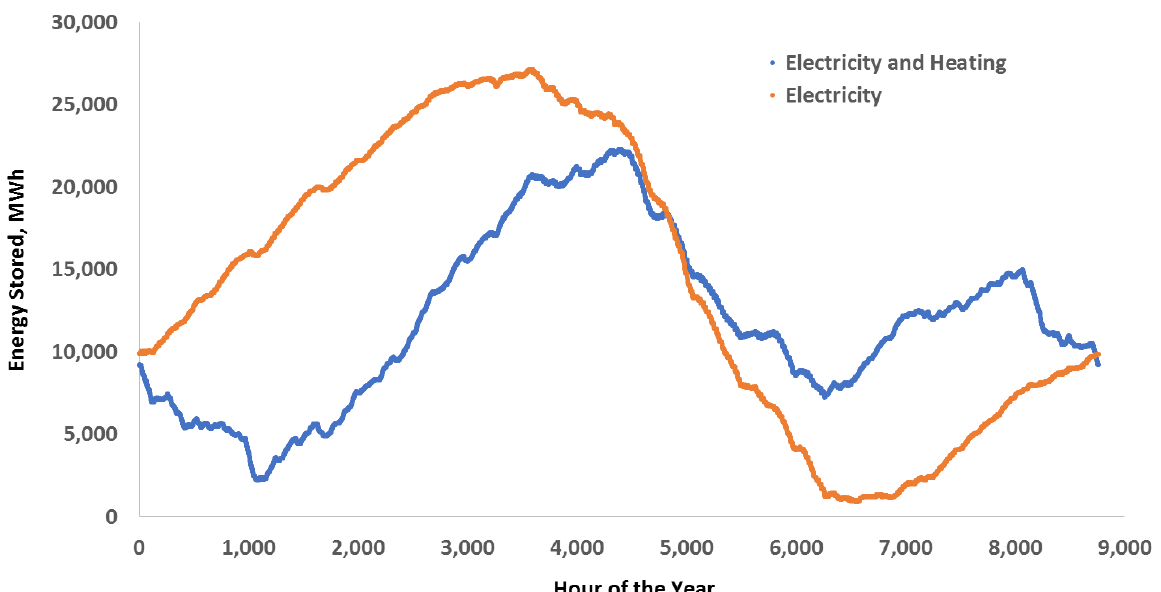
Figure 7. Hourly hydrogen energy storage needed in the two cases examined. Hour 1 corresponds to the first hour of the year (midnight to 1 a.m. on 1 January).